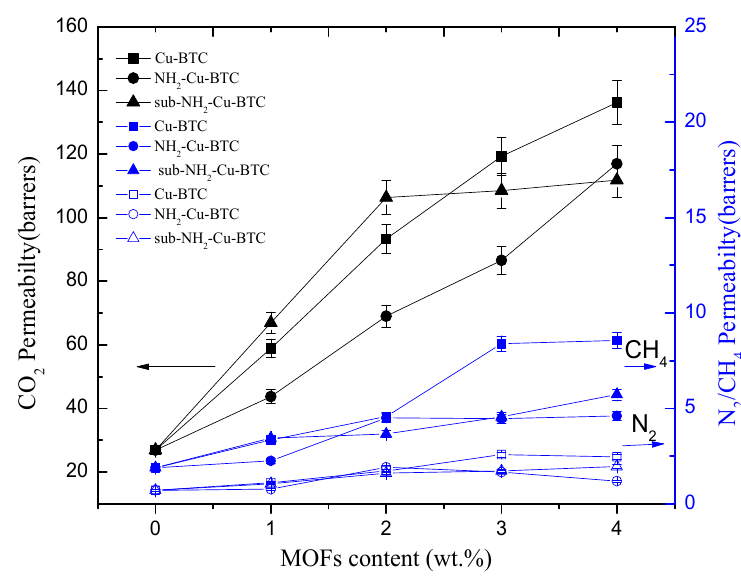
Figure 8. Effects of the MOFs loading level on the gas permeability of MMMs.